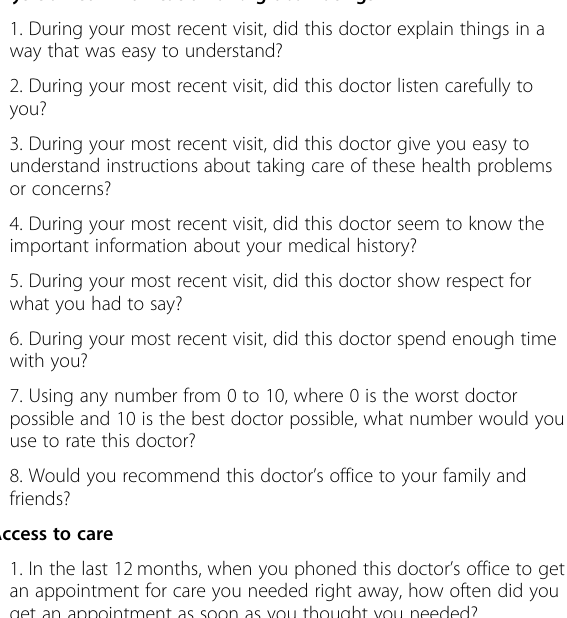
Table 2 CAHPS clinician and group adult visit survey 1.0